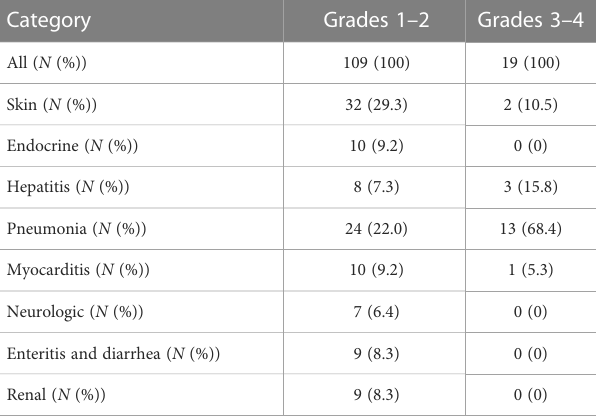
TABLE 3 Immune-related adverse events according to category and